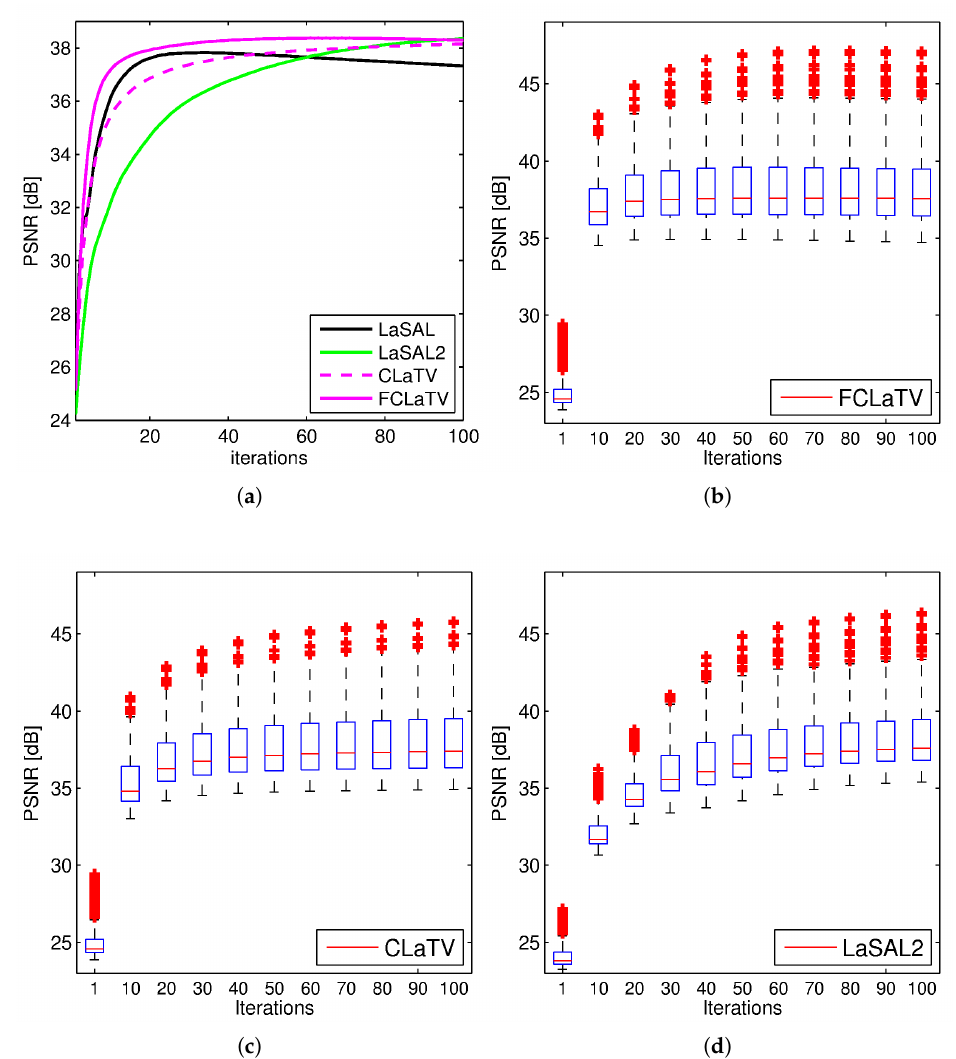
Figure 4. PSNR values obtained from 248 MRI brain slices from the first data set, with radial sampling (SR 25%). Mean PSNR ( a ) and the PSNR distribution for FCLaTV ( b ), CLaTV ( c ), LaSAL2 ( d ). The result is presented as a box plot: the edges of the each box represents 25th and 75th percentile while the central mark (red line) in the box is median. The whiskers extend to the most extreme PSNR values which are not considered outliers while outliers are plotted separately with red